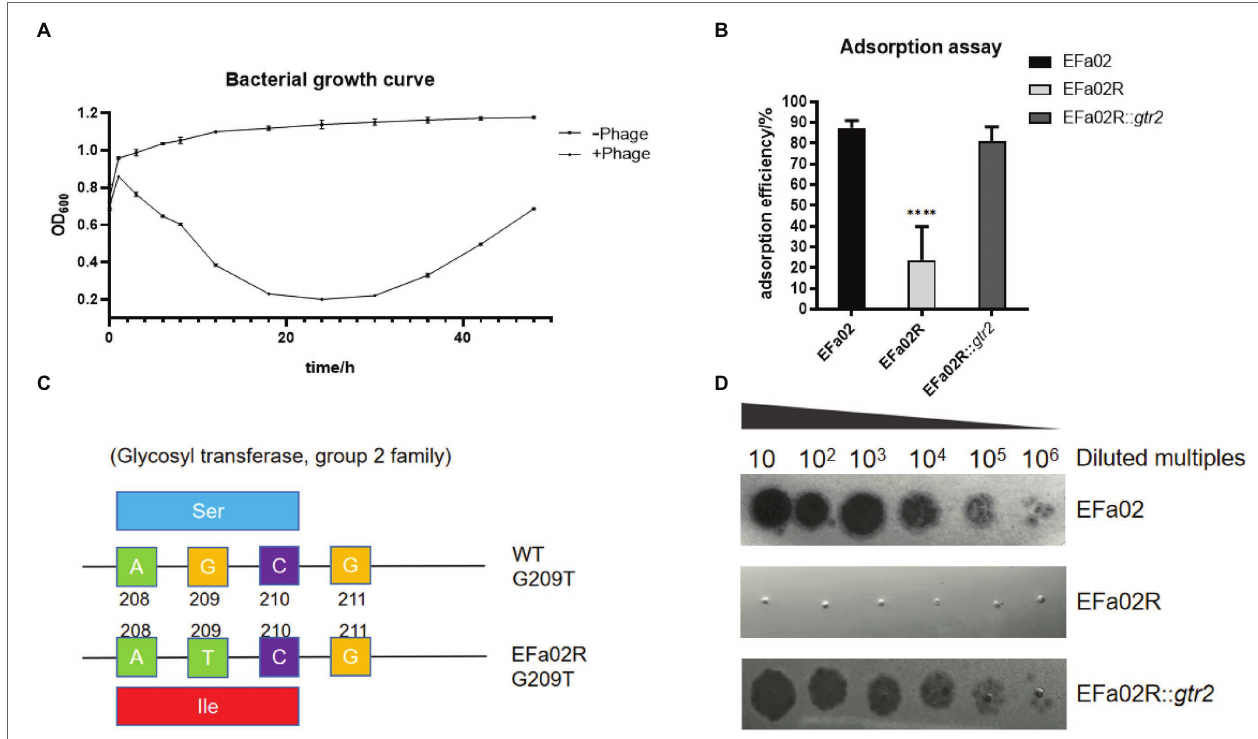
FIGURE 5 | (A) Growth curve of the phage–bacteria coculture. Thirty hours after phage addition, the OD 600 of the phage and bacteria coculture began to increase. (B) Adsorption rate of phage onto three strains. This result indicates that EFap02 can adsorb EFa02 and EFa02R:: gtr2 but not EFa02R ( **** p < 0.0001). (C) The mutation site of the glycosyltransferase Group 2 gene in EFa02R; the mutant site is G209T, which results in the amino acid change from serine to isoleucine. (D) EOP assay indicates that EFap02 can infect EFa02 and EFa02R:: gtr2 but not EFa02R.